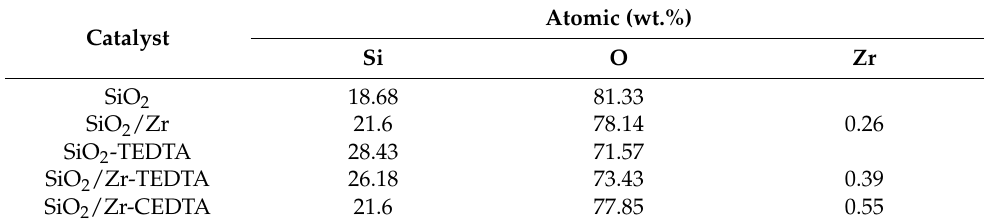
Table 1. EDX results of SiO 2 , SiO 2 /Zr, and their